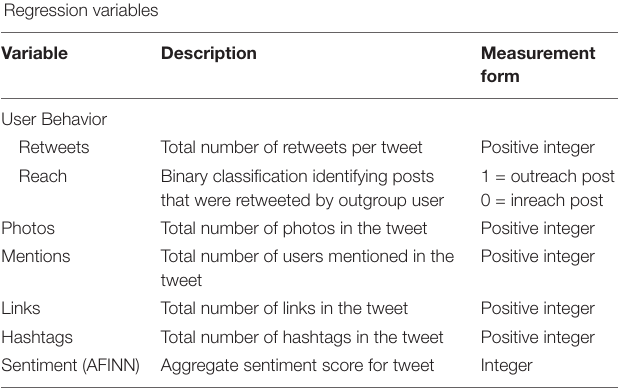
TABLE 3 | Variables included in each regression